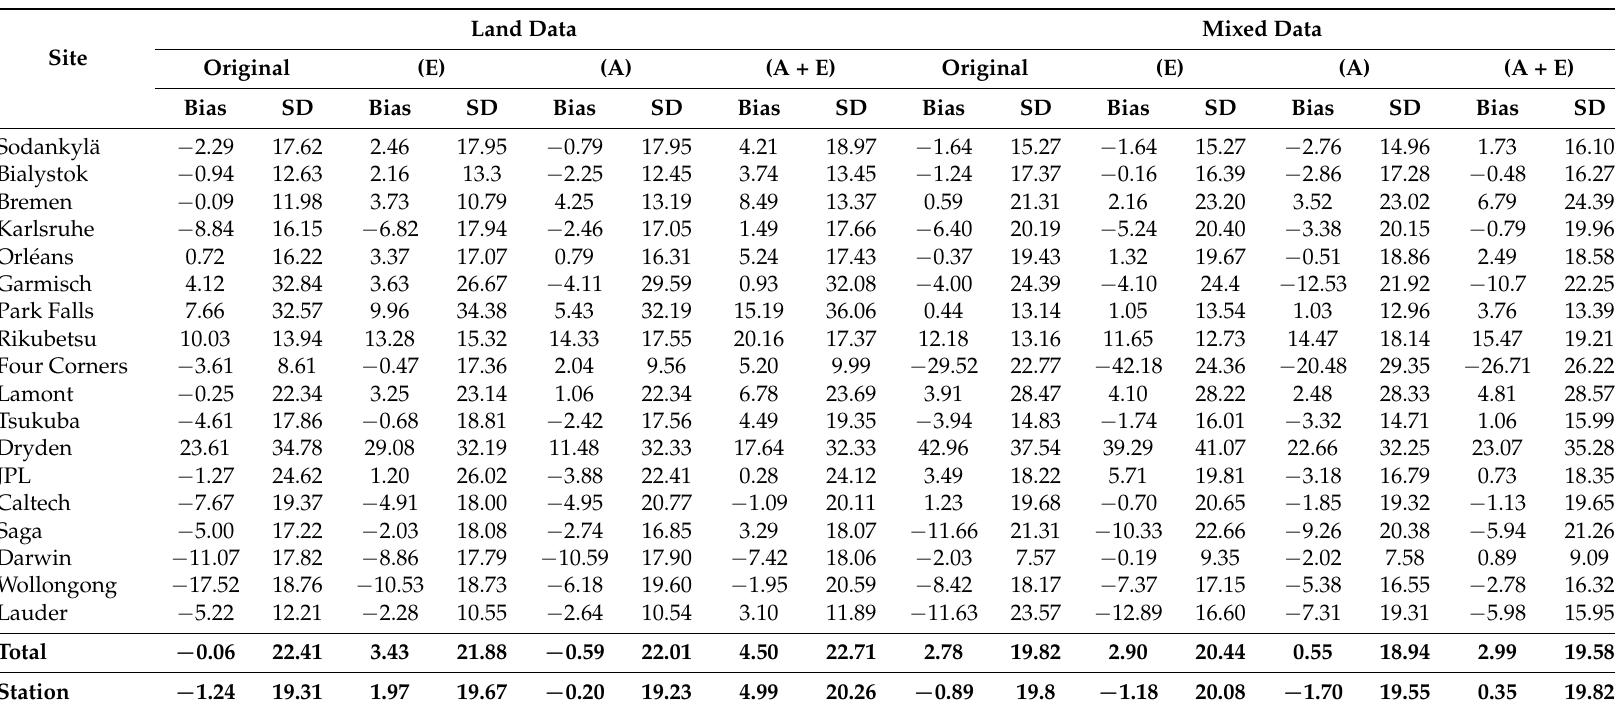
Table 7. Comparison of biases and standard deviations (SD) among the three bias correction methods at 18 the TCCON sites for case 2. (E) Empirically derived bias correction, (A) altitude bias correction, and (A + E) altitude bias correction followed by empirically derived bias